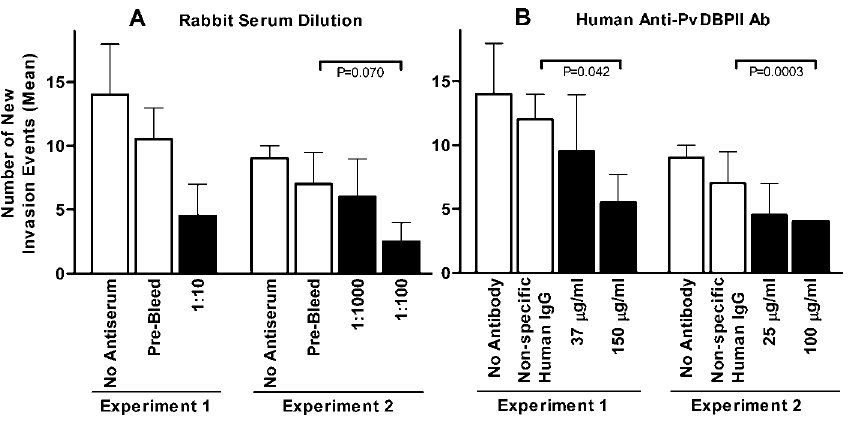
Figure 4. Inhibition of P. vivax Invasion of Human Red Blood Cells by Anti-PvDBPII Ab Tests were performed to examine the influence of rabbit (A) and human (B) anti-PvDBPII Ab on P. vivax invasion on a patient sample cultured in PvCM plus 20% AB serum (Experiment 1) or a sample from a second patient cultured in PvCM plus 25% AB serum (Experiment 2). Control cultures (white bars) contained media without antibodies and were the same for both experiments. The concentration of antibodies (pre-bleed rabbit serum or nonspecific human IgG) in the positive control cultures (white bars) was equal to the highest concentration of test serum. Various concentrations of the test antibody (black bars) were added to late-stage P. vivax cultures and grown for 24 h (in duplicate), and the number of newly invaded cells was observed by light microscopy based on examination of 200 high-powered fields of Giemsa-stained thin smears or approximately 20,000 erythrocytes. Bars indicate mean 6 standard deviation of the number of invasion events. p -Values (two-sided t -test) are shown for differences of p , 0.1 between test samples and their respective control